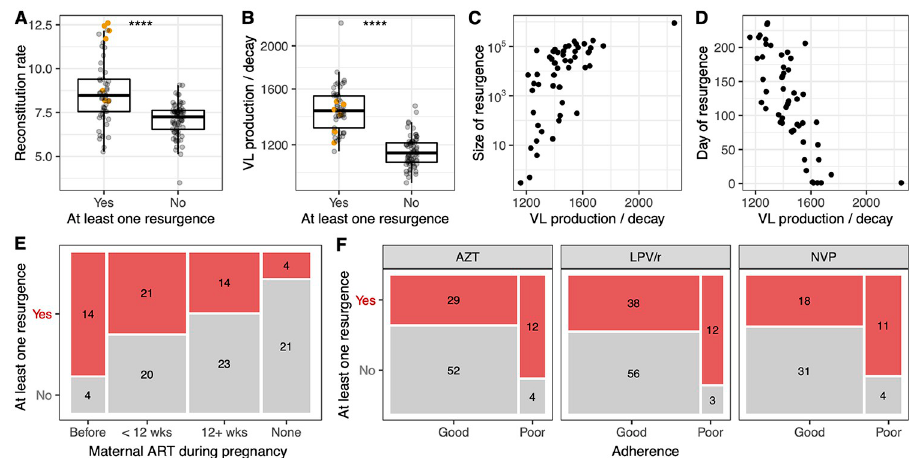
Fig 4. VL resurgence is associated with rates of CD4 reconstitution, VL production and decay, and ART history of infant and mother. (A–B) Relationship between the occurrence of VL resurgence (defined as any increase in VL following initiation of ART) and the CD4 reconstitution rate, r , in cells μ l -1 day -1 (A) and the ratio of virus production to decay, � p ¼ p = c , in copies ml − 1 cell − 1 (B). Each point represents a different infant and p < 0.0001( ���� ) in both cases. Seven infants whose resurgence was a viral rebound event are highlighted in orange. (C–D) Relationship between � p and the size of VL resurgence in RNA copies ml − 1 (C) and timing of VL resurgence in days (D). Each point represents an infant who experienced resurgence. Correlations are 0.66 and -0.75, respectively, and p < 0.0001 in both cases. (E) Relationship between the occurrence of VL resurgence and the timing of maternal ART initiation ( p < 0.01). The size of each box reflects the proportion of infants in the corresponding category and the numbers show the corresponding sample size. (F) Relationship between infant ART adherence and the occurrence of VL resurgence ( p < 0.05 for AZT and LVP/r; p = 0.06 for NVP). Adherence was classified as ‘good’ if the majority of adherence estimates were 90% or more, and ‘poor’